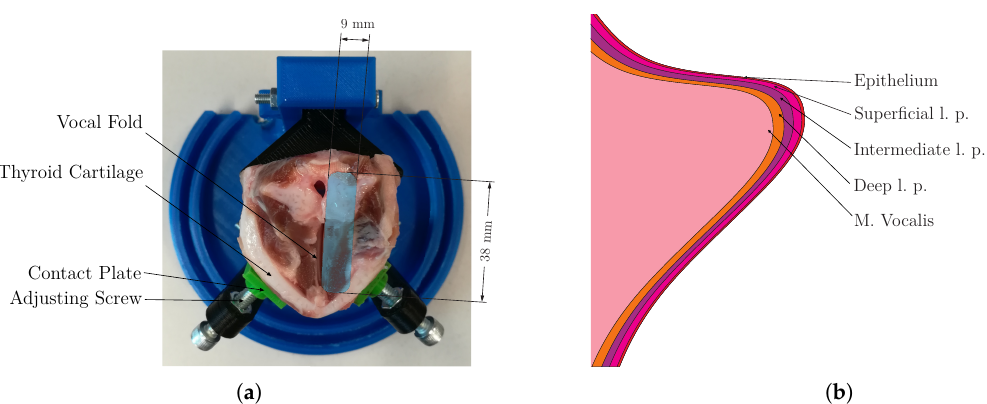
Figure 1. Anatomical and histological properties of the vocal folds (VFs). ( a ) Porcine vocal folds fixed in the holder. The blue area indicates the transducer position. ( b ) Layers of the human VF: epithelium, lamina propria (l.p.) and musculus (M.) vocalis